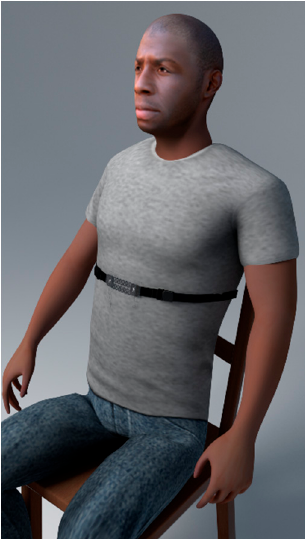
Figure 10. The inkjet-printed (IJP) PDMS-based sensor attached to a human at the upper part of the abdomen.